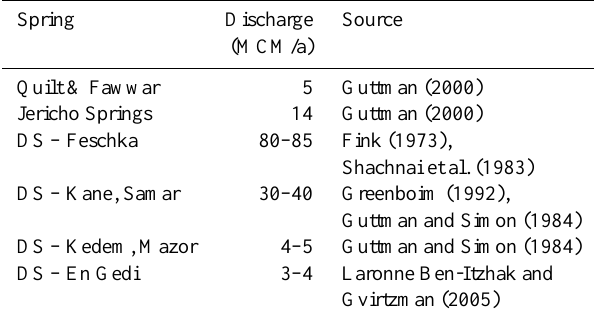
Table 2. Annual spring discharge of know spring locations within the study area (DS: Dead Sea shore).